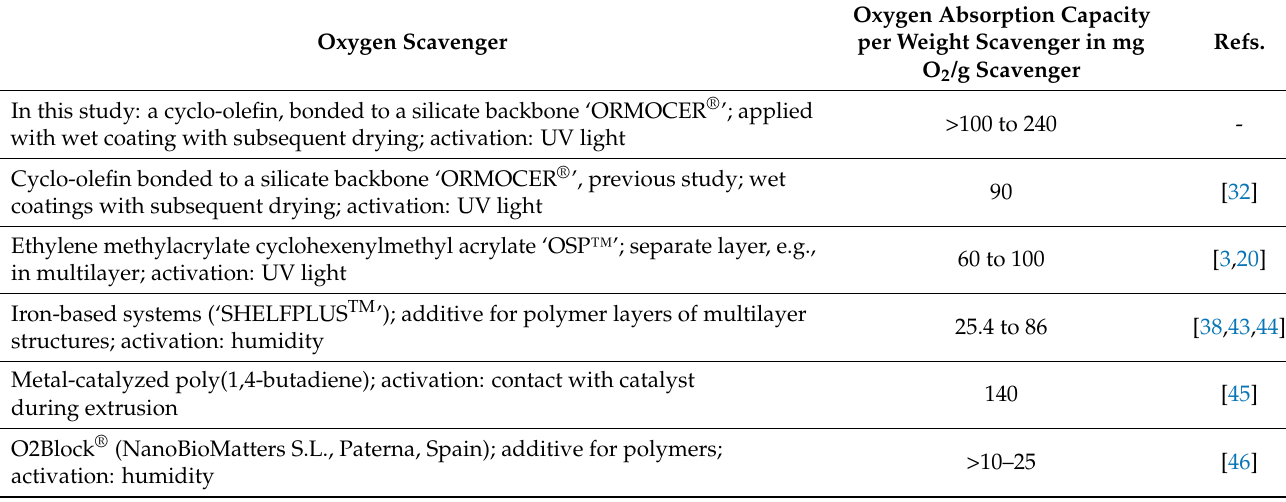
Table 1. Oxygen absorption capacities of different oxygen